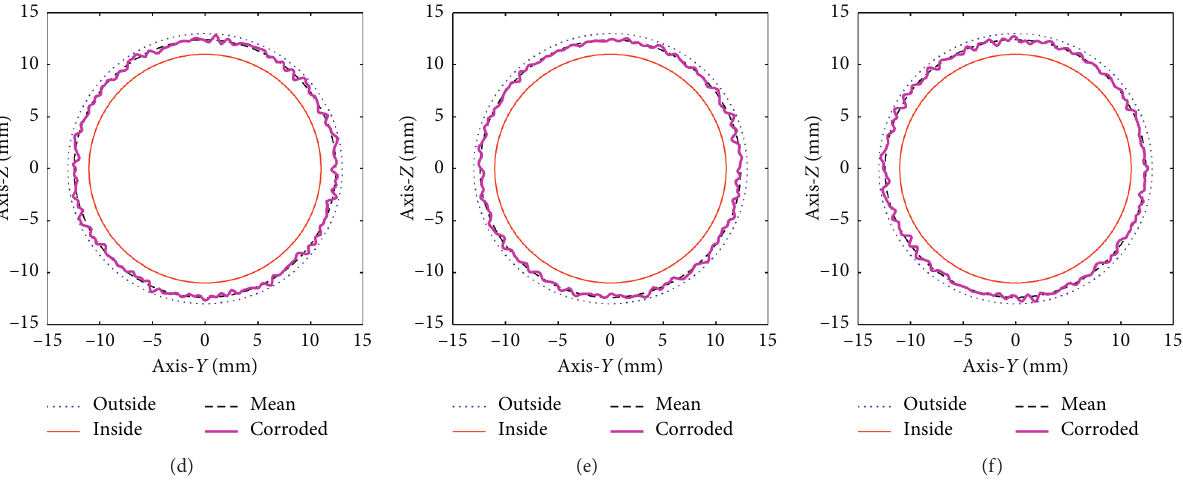
Figure 4: The topology of corroded section along the axis of pipe. (a) X � 0. (b) X � L /5. (c) X � 2 L /5. (d) X � 3 L /5. (e) X � 4 L /5. (f) X � L .